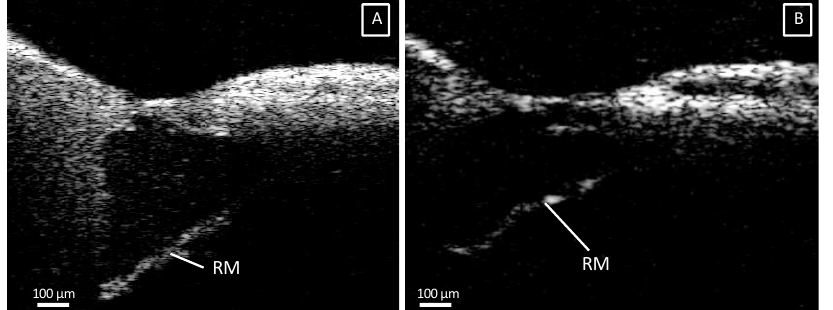
Figure 6. ( A ): Illustration of a straight Reissner’s membrane (RM), compared to an irregular, slightly concave towards the scala media ( B ). OCT images were taken with an a-scan rate of 76 kHz. Abbreviations: Reissner’s membrane (RM).